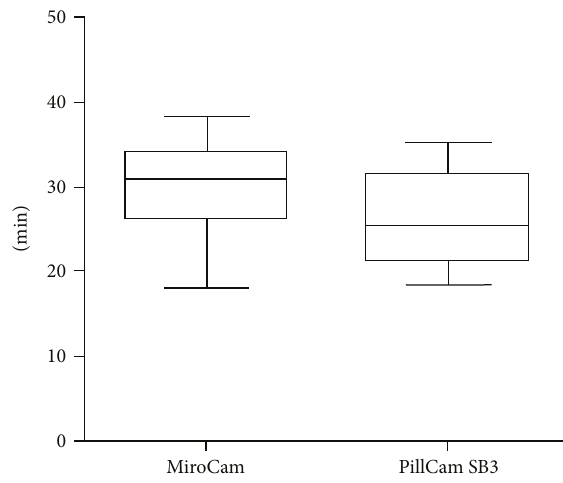
Figure 3: Comparison of reading times (MiroCam versus PillCam SB3